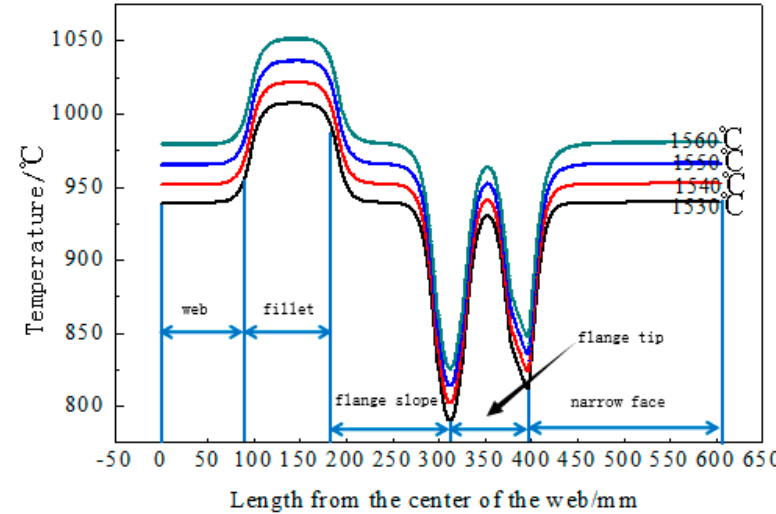
Figure 16. Temperatures along the outer boundary at different pouring temperatures.